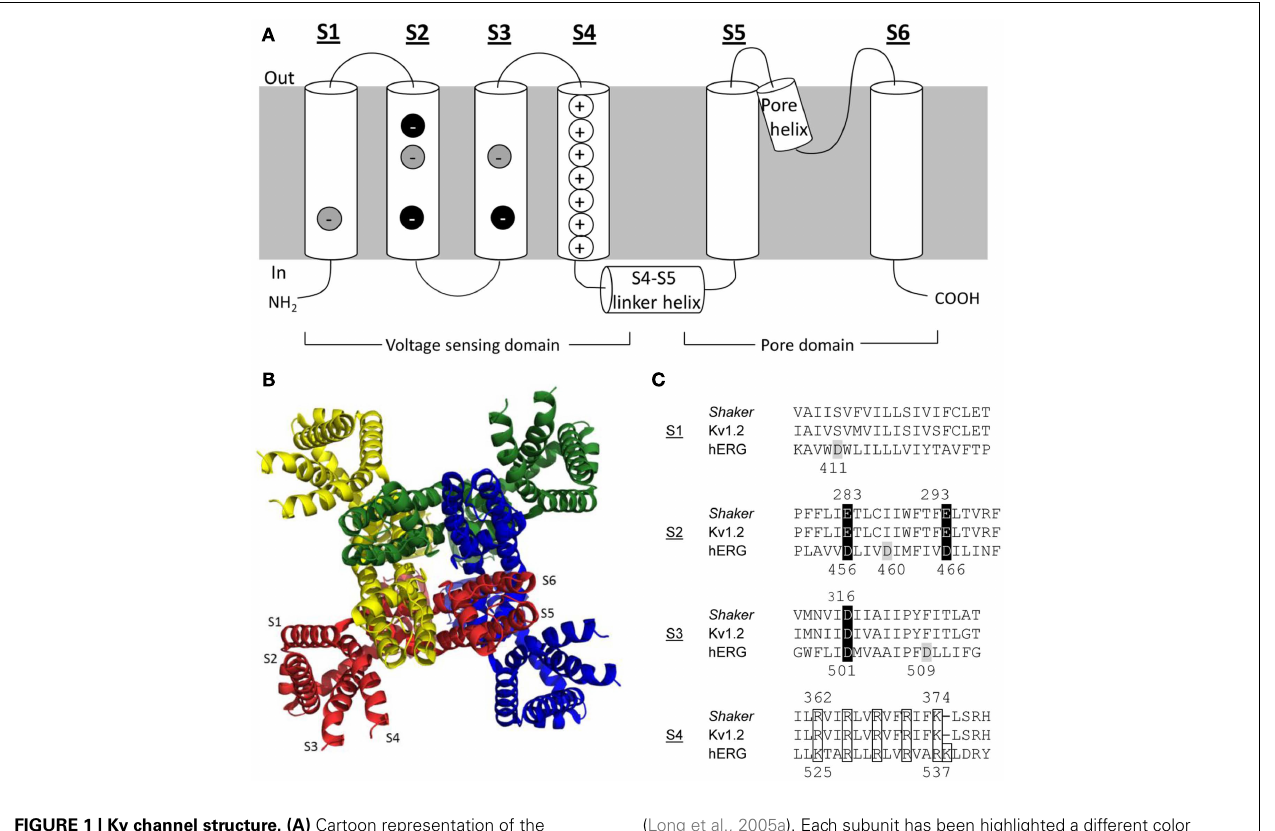
FIGURE 1 | Kv channel structure. (A) Cartoon representation of the membrane topology of a Kv channel α -subunit. Key charged residues within the voltage-sensing domain are highlighted. Negative charges highlighted in black are highly conserved, whereas those in gray are conserved only in the eag channel family. (B) Ribbon representation of the Kv channel tetrameric assembly based on the Kv1.2 crystal structure